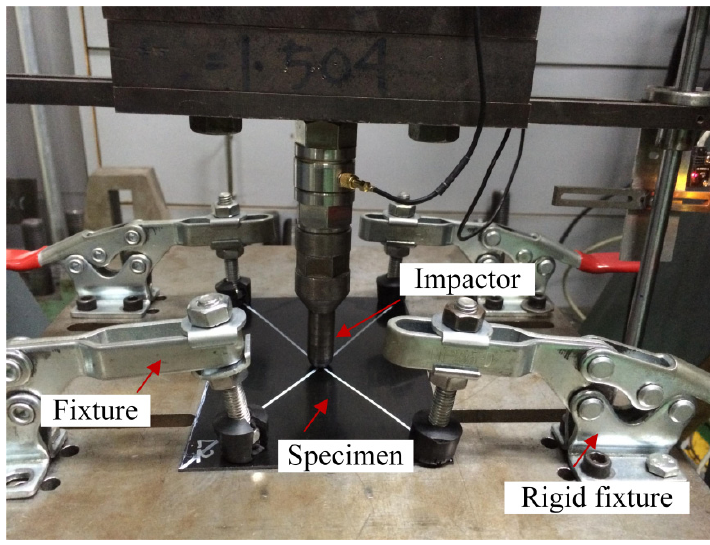
Figure 4. Low velocity impact experiment system.